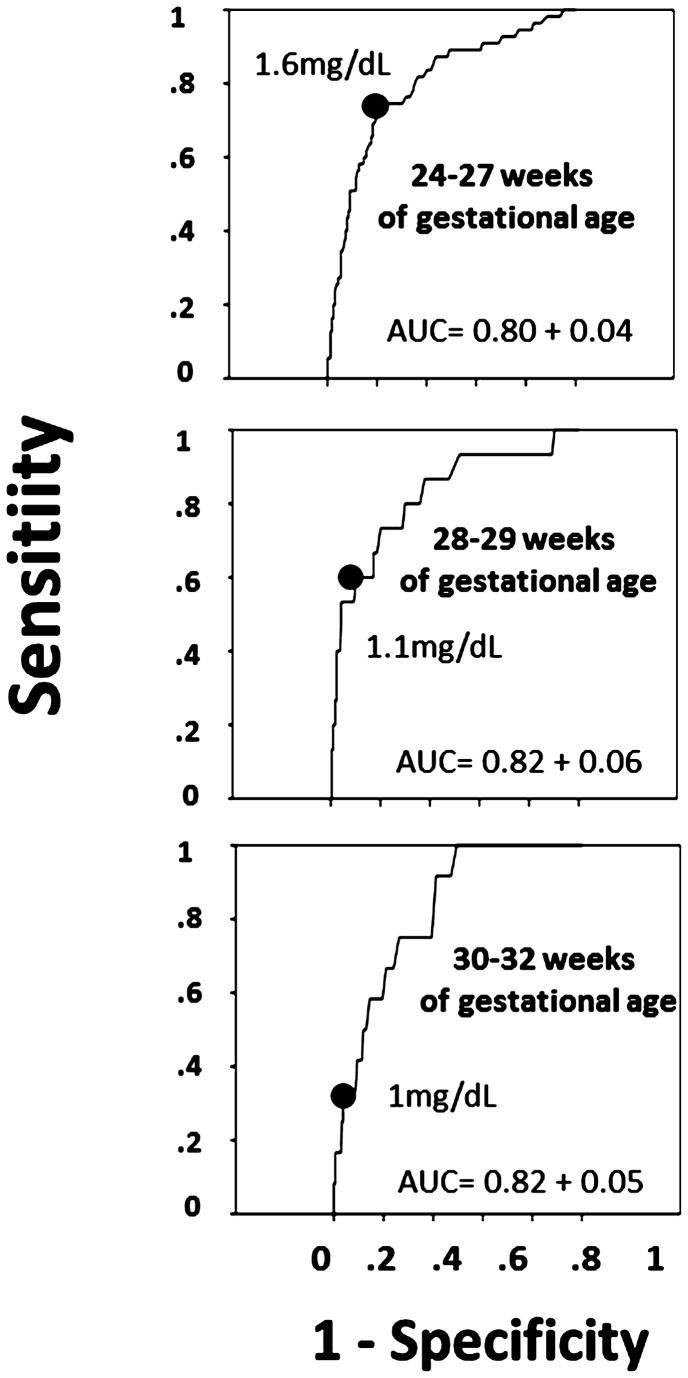
Critical values of creatinine (indicated by black circle) and receiver operating curve for creatinine to predict mortality, according to gestational age, in validation set.